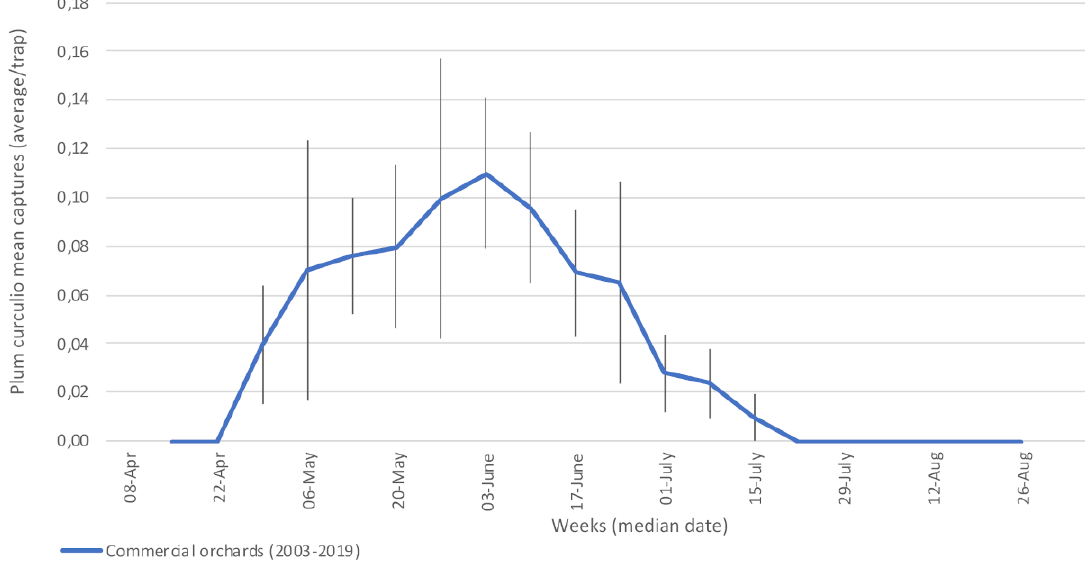
Figure 4. Average captures of plum curculio adults in participating orchards, 2003–2019. Commercial orchards located at Franklin, Hemmingford, Henryville, Rougemont, Saint-Bruno-de-Montarville and Saint-Paul-d’Abbotsford. Vertical bars represent standard